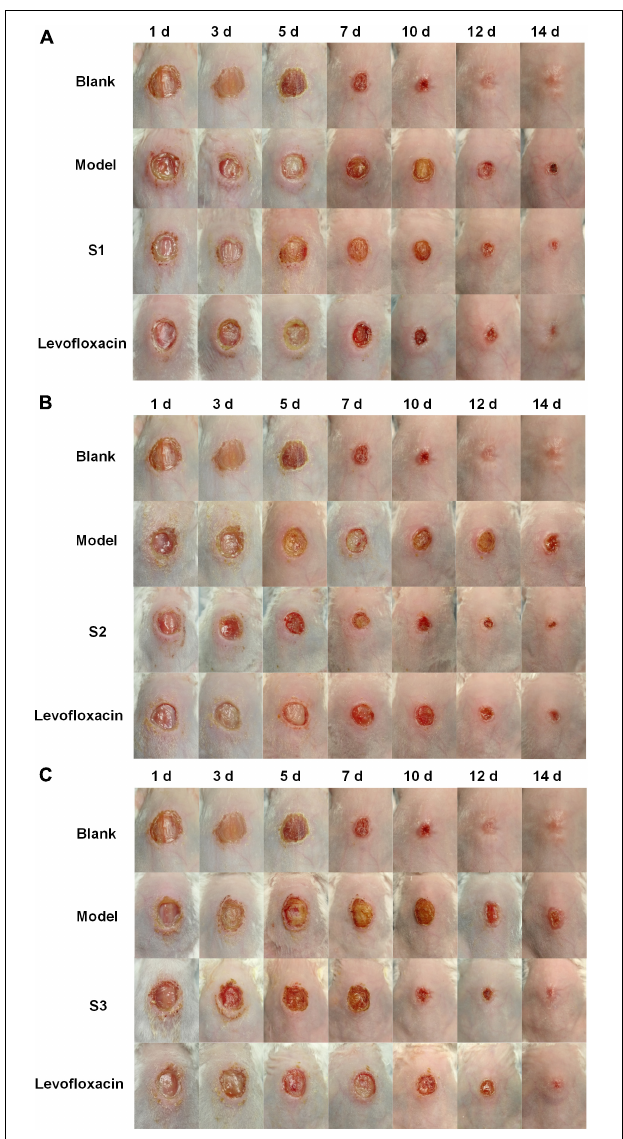
FIGURE 5 | The effects of S1, S2, and S3 on promoting wound healing. The healing of wounds on days 1, 3, 5, 7, 10, 12, and 14 in mice skin infected